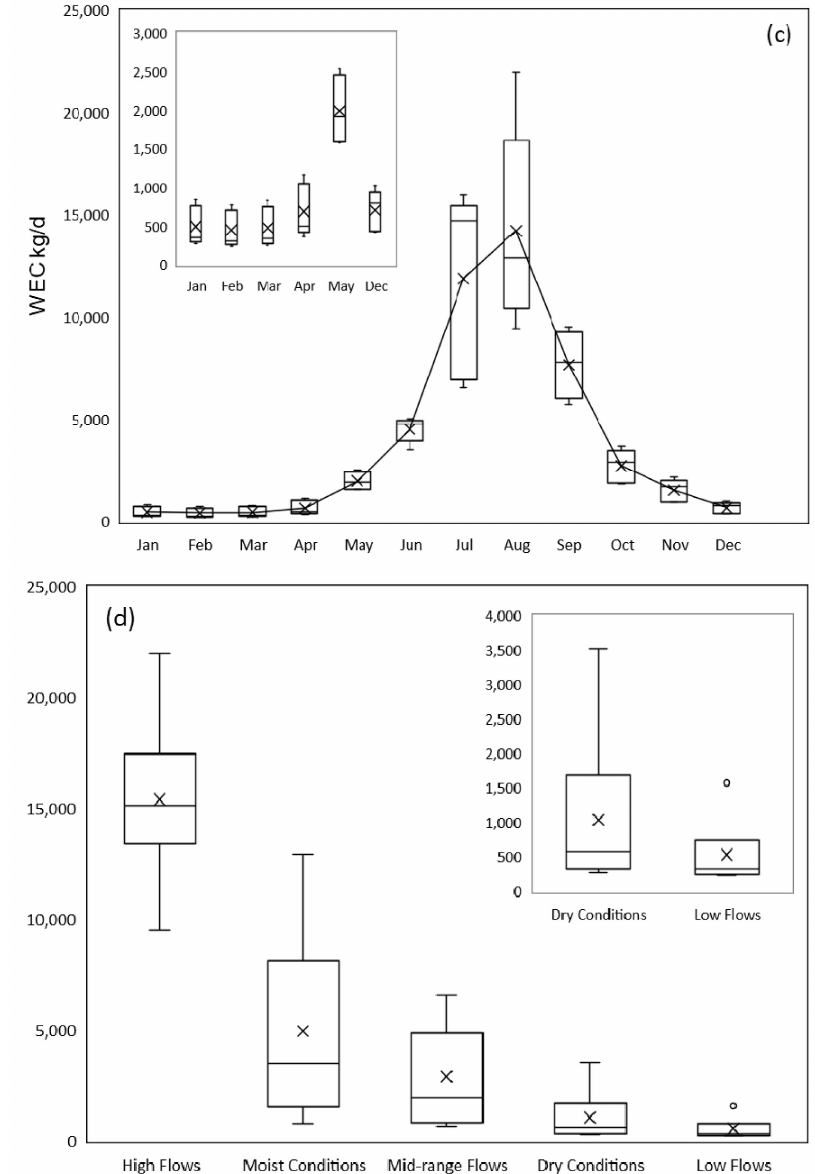
Figure 8. Comparison of MHE model, Liu-model (end-control model), Zhao-model (head-control model), and the traditional LDC model in the outlet subbasin under: ( a ) time series from 2012 to 2016; and ( b ) different flow regimes. ( c , d ) Capacity variations from the MHE model of outlet subbasin at different months and flow regimes,